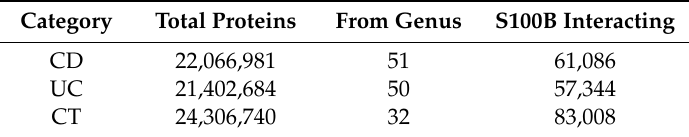
Table 2. S100B potentially interacting bacterial proteins in the three categories and their genus of provenance.